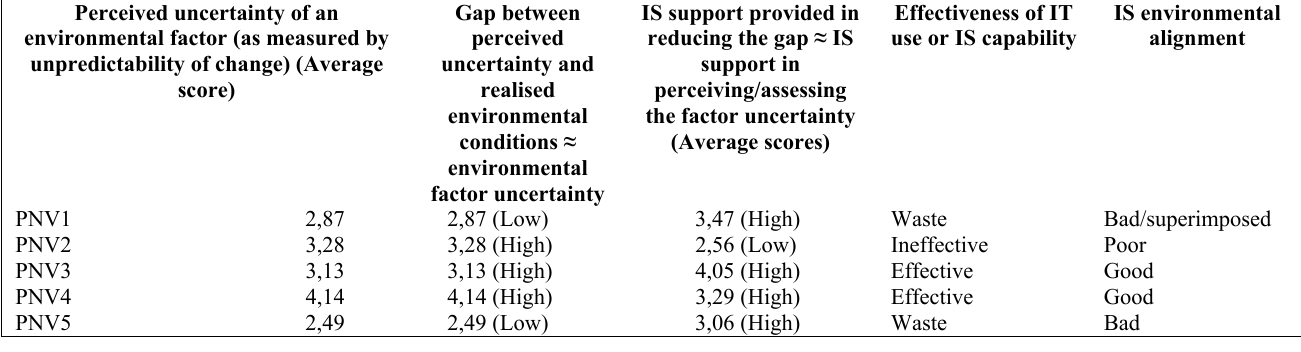
Waste Effective IT use ( Bad or superimposed (Good